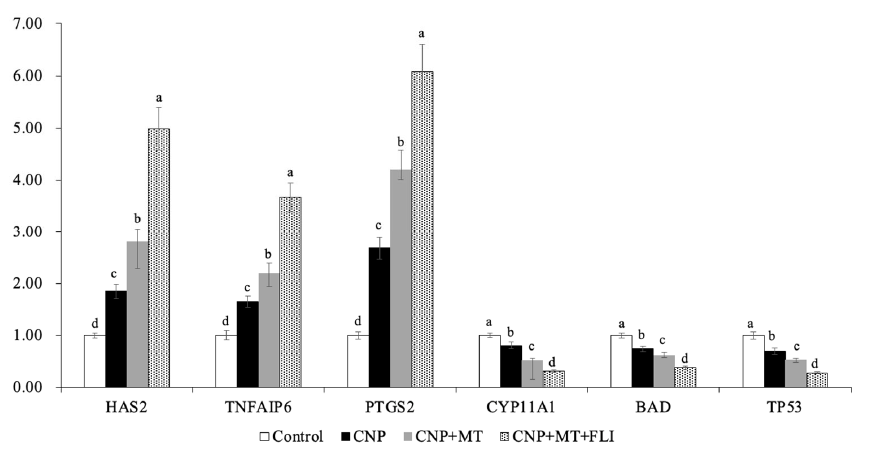
Figure 7. Effect of the combination treatment of CNP, MT, and FLI on the gene expression in CCs. a, b, c, d Values with different superscripts indicate significant differences between groups ( p < 0.05).